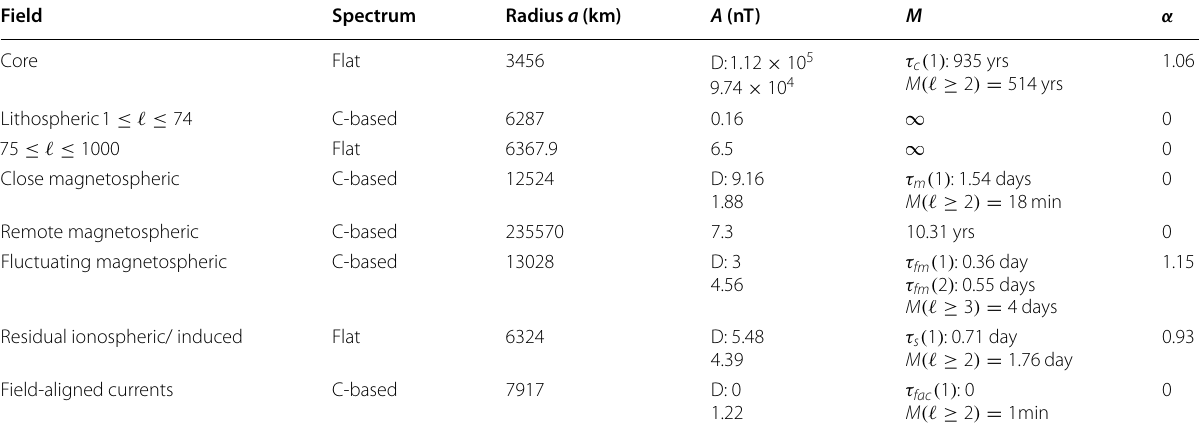
The prior spatial covariance matrices are derived from energy spectra expressed at some radii a s which are either flat with E ∞ s (ℓ) = A 2 s or of the C-based type [see Holschneider et al. (2016)] with the form E ∞ s (ℓ) = A 2 s ( 2 ℓ + 1 ) R (ℓ) , where R (ℓ) = ℓ + 1 and R (ℓ) = ℓ for, respectively, internal and external sources The characteristic timescales are parameterized by τ s (ℓ) = M s ℓ − α